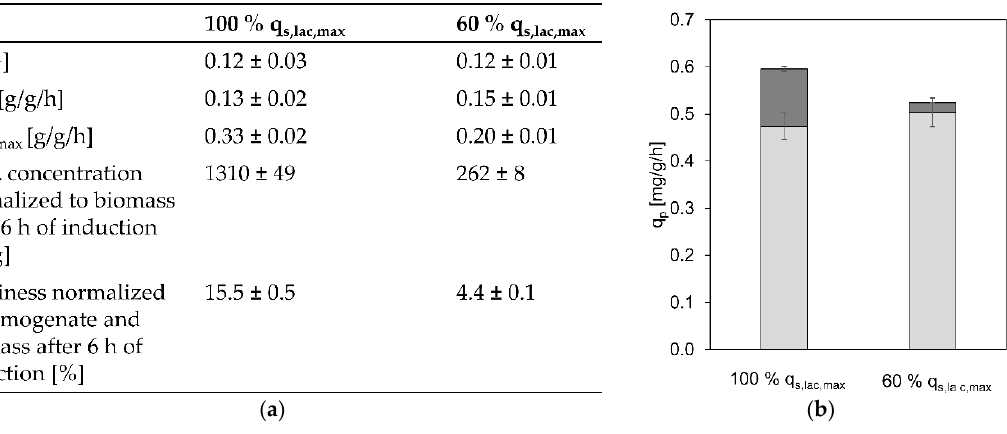
Figure 4. Physiology, leakiness, lysis and productivity at 100% and 60% q s,lac,max ( a ) Comparison of physiological data as well as leakiness and lysis of a cultivation at a q s,glu 0.14 g/g/h and different q s,lac (100% q s,lac,max and 60% q s,lac,max ); ( b ) specific overall, intracellular (light grey), and extracellular (dark grey) product formation rates of cultivations at 100% q s,lac,max and 60% q s,lac,max .